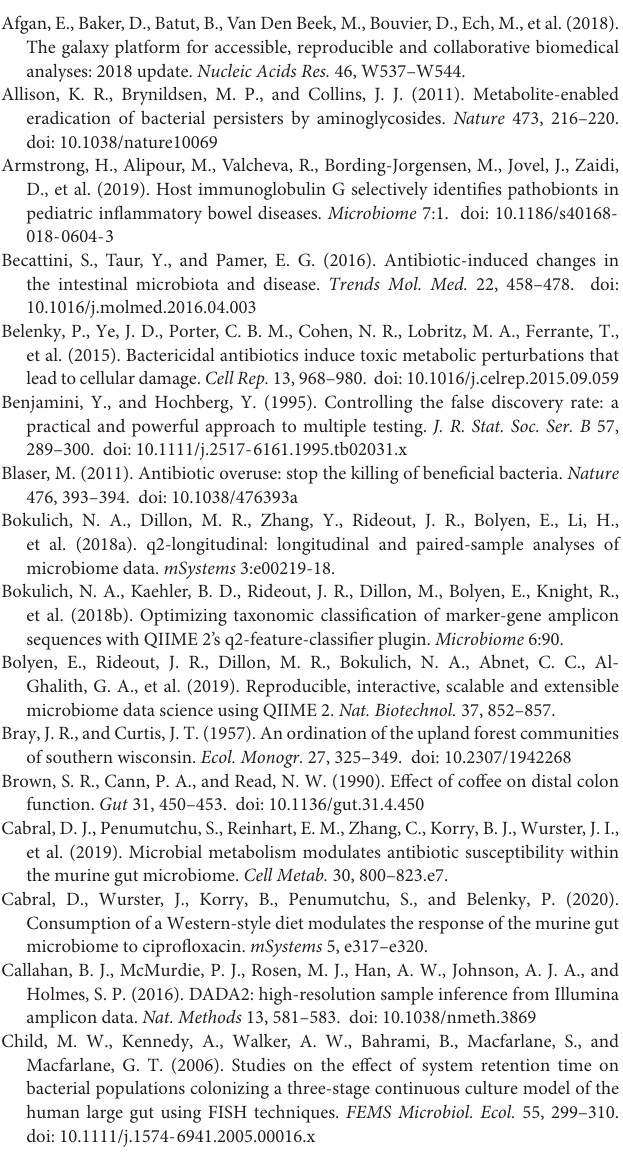
coffee (decaf, purple), or caffeinated coffee (caf, pink). Significance between different experimental groups is denoted by squares color-coded according to the experimental groups being compared. Solid squares represent groups without antibiotics, open squares represent groups given antibiotics. Each comparison of two experimental groups has its corresponding significance denoted in stars (*) next to it. n = 6. Supplementary Figure 2 | Relative abundance of bacterial phyla over the course of the experiment. Dotted line denotes beginning of antibiotic treatment. (A) Control, (B) Control + amoxicillin days 5–12, (C) Decaf, (D) Decaf + amoxicillin days 5–12, (E) Caf, (F) Caf + amoxicillin days 5–12. n = 6. Supplementary Figure 3 | Linear discriminant analysis effect size (LEfSe) analysis between treatment groups on day 7 at the phylum level (A,C,E,G,I) , and at the family level (B,D,F,H,J) . Histogram of LDA scores plotted on a log 10 scale.